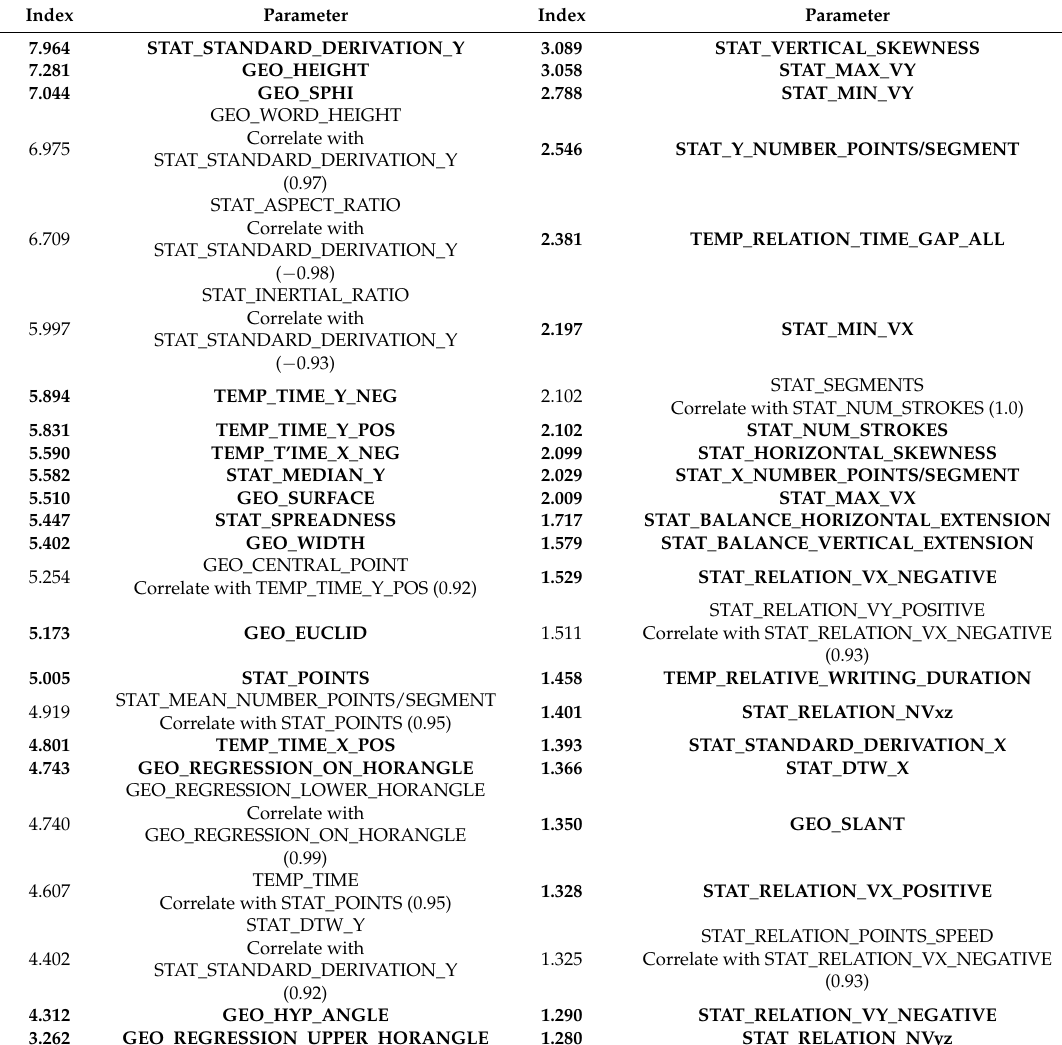
Table 6. Fisher Scores Secure Password DB 150 Attributes which have a greater score than the 30% quantile in Secure Password DB 150.